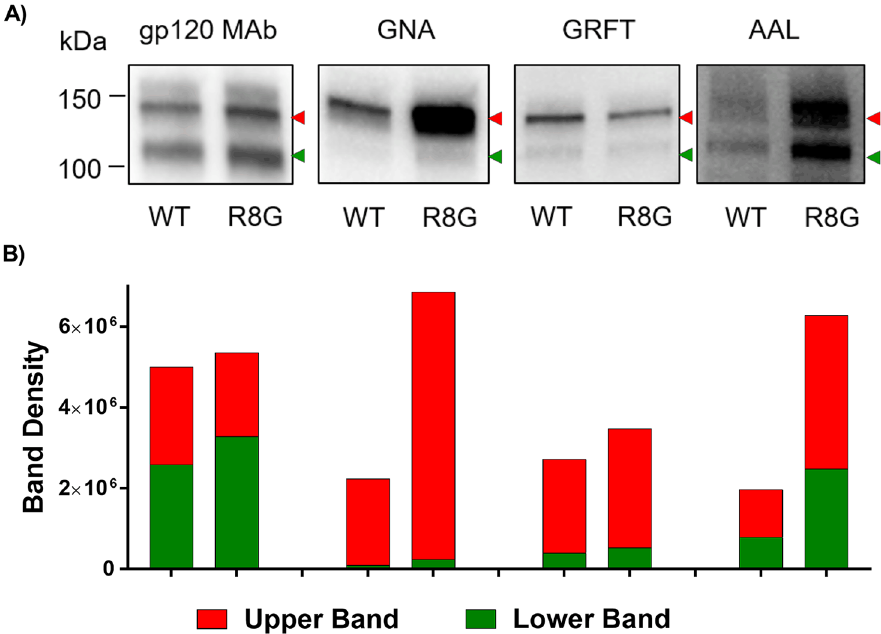
Fig 11. Analysis of JRFL Env sugar moieties by lectin-probed Western blotting. The same amounts of Env from JRFL WT and mutant viruses produced in 293T cells were separated by SDS-PAGE (10%) under reducing condition, blotted, and probed with an anti-gp120 MAb cocktail or lectins (GNA, GRFT, and AAL). A) Env reactivity with MAbs versus lectins. Two Env species with distinct molecular masses are indicated by red and green arrows. B) Density measurements of the upper and lower Env bands as recognized by anti-gp120 MAbs and different lectins. Density analysis was done by Image Lab software.